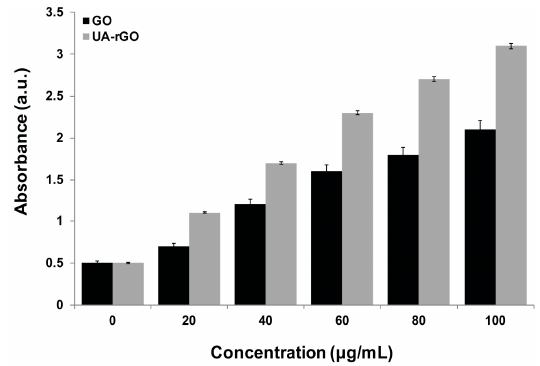
Figure 10. GO and UA-rGO induce ROS generation in human ovarian cancer cells. Relative fluorescence of 2 1 ,7 1 -dichlorofluorescein was measured at the excitation of 485 nm and emission of 530 nm using a spectrofluorometer. The results are expressed as the mean ˘ standard deviation of three independent experiments. The treated groups showed statistically significant differences from the control group by the Student’s t -test ( p <